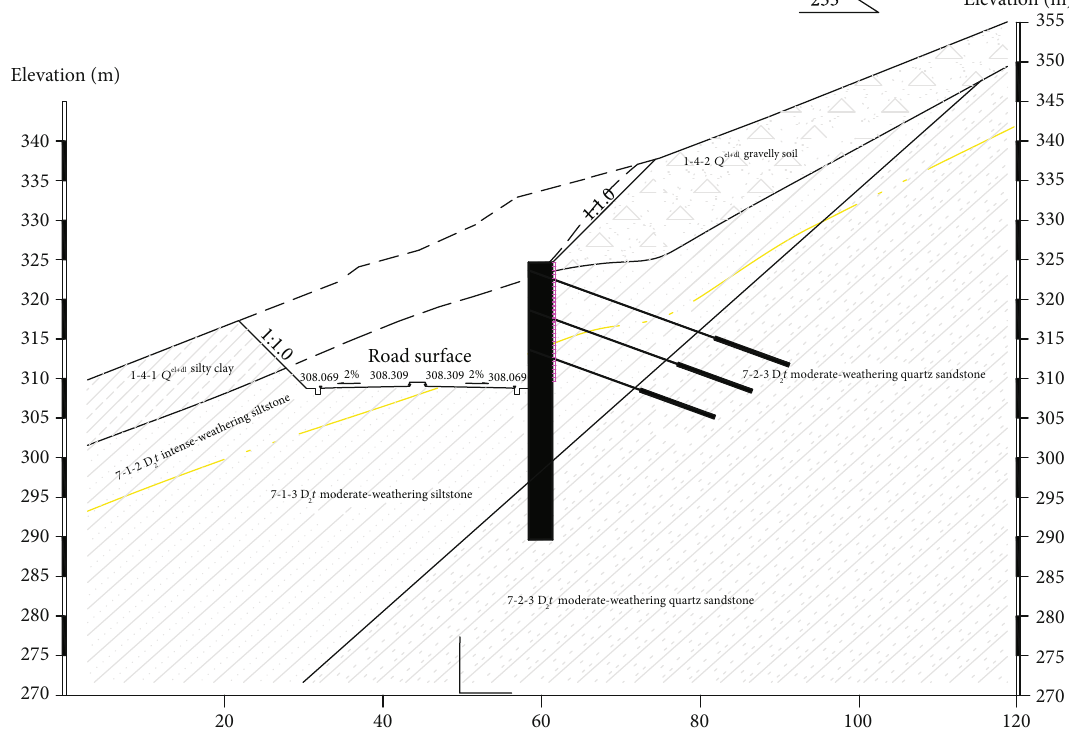
Figure 4: Engineering geology cross-section pro fi le with reinforcement work of the cut slope (B-B ’